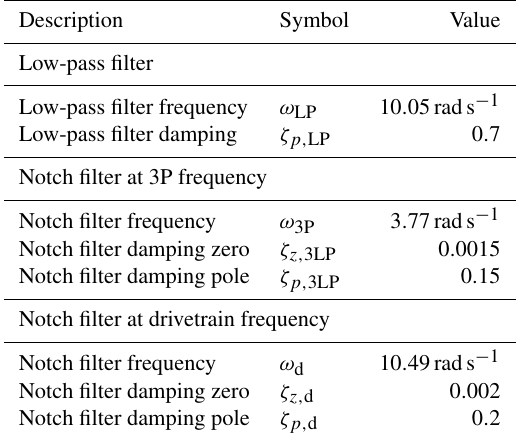
Table 2. Filter parameters of the different controller